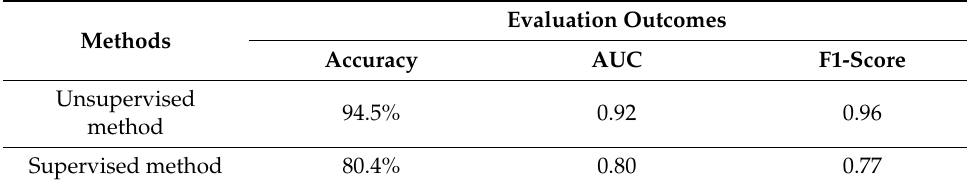
Table 1. Comparison of unsupervised and supervised learning methods.